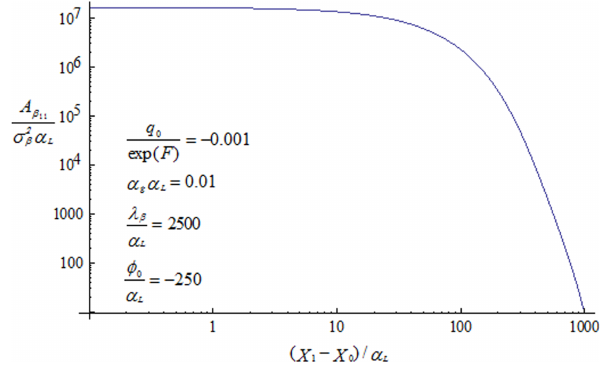
Fig. 1. Dimensionless component of the longitudinal macrodisper- sivity as a function of dimensionless ln K s correlation scale.